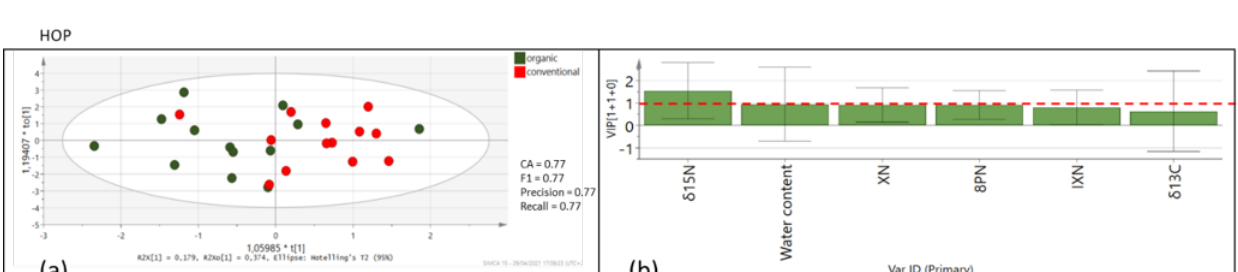
Hops samples, Table S2: Beer samples, Table S3: Parameters of the LC-MS/MS method, Table S4: Validation data for hops, Table S5: Validation data for